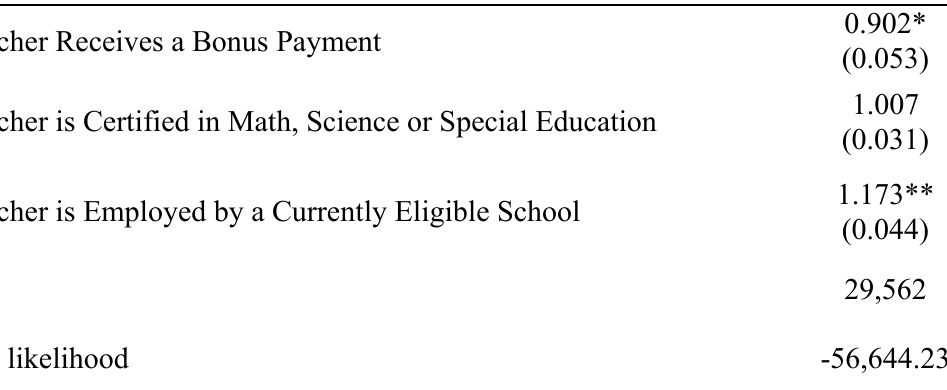
Table 3 : Basic Estimate of the Program’s